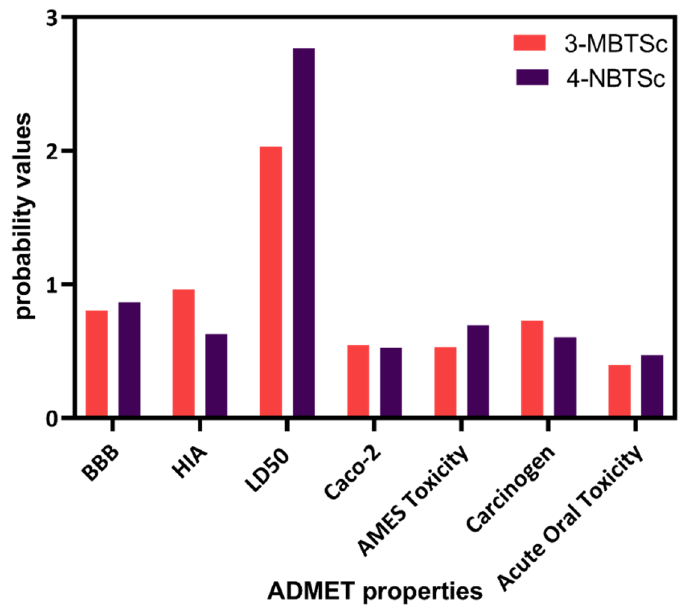
Figure 2. Comparative ADMET properties of 3-MBTSc and 4-NBTSc compounds.